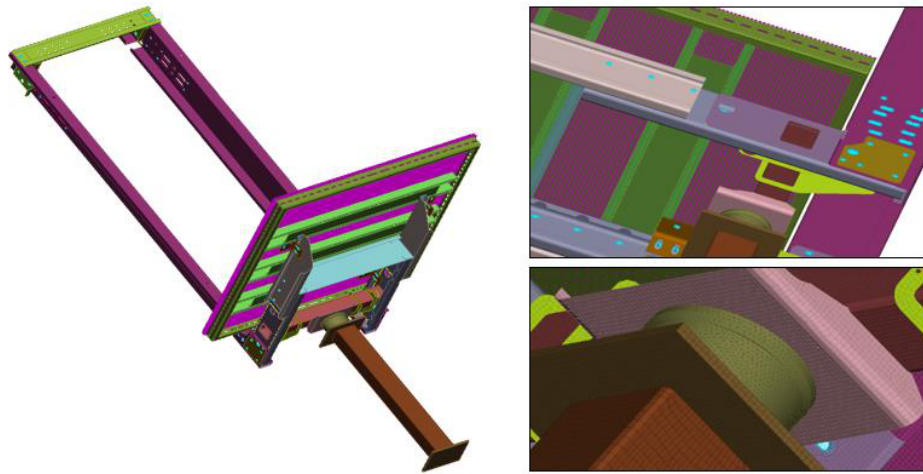
Figure 12. New-design elevator chassis FE model.